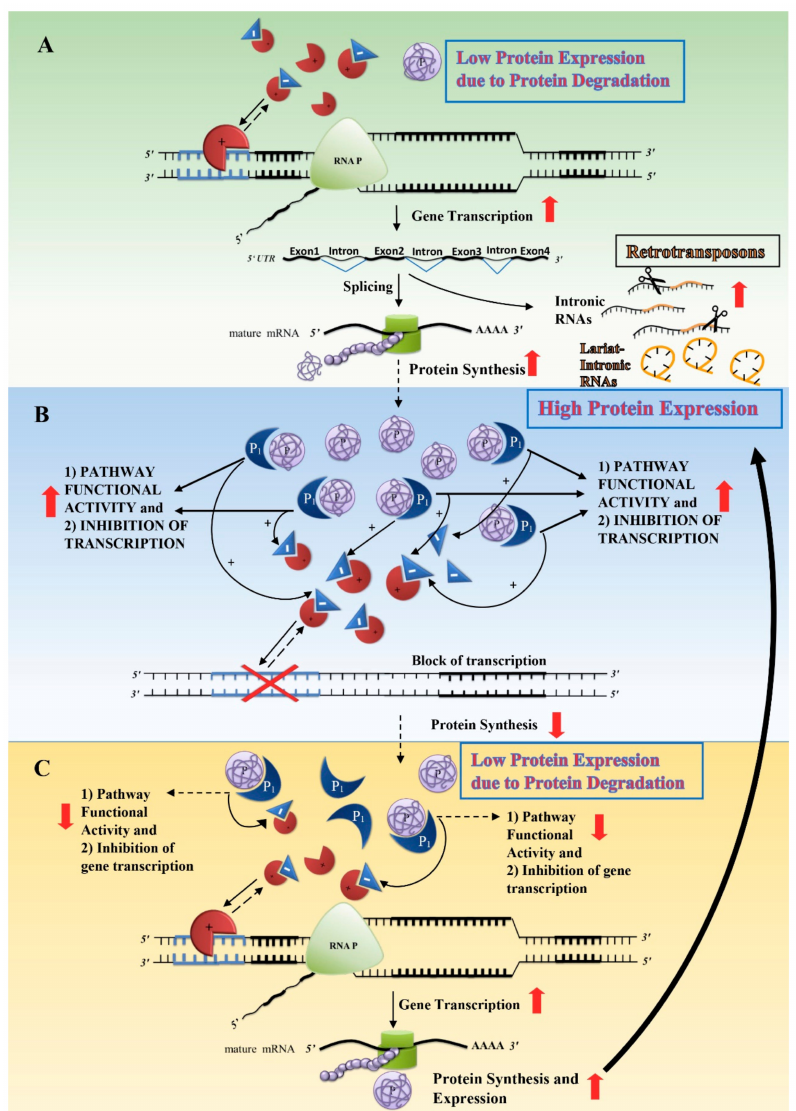
Figure 2. Cellular homeostatic mechanisms regulate optimal cellular protein concentrations in normal environmental fluctuations. Sequential steps ( A – C ) of cyclic protein synthesis and protein